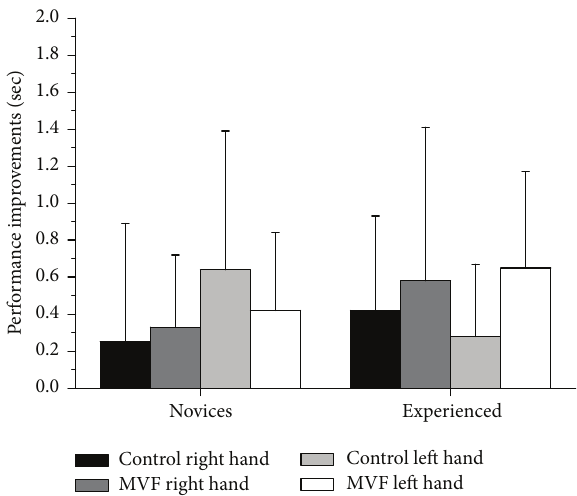
Figure 5: Shown are the performance improvements in the time for slalom dribbling parkour execution (i.e., slalom performance) calculated by subtracting prevalues from postvalues and separated for novice and experienced groups. These scores are absolute means, anderrorbarsindicatestandarddeviations.Thehigherthevalue,the greater the improvement; statistics are explained in the